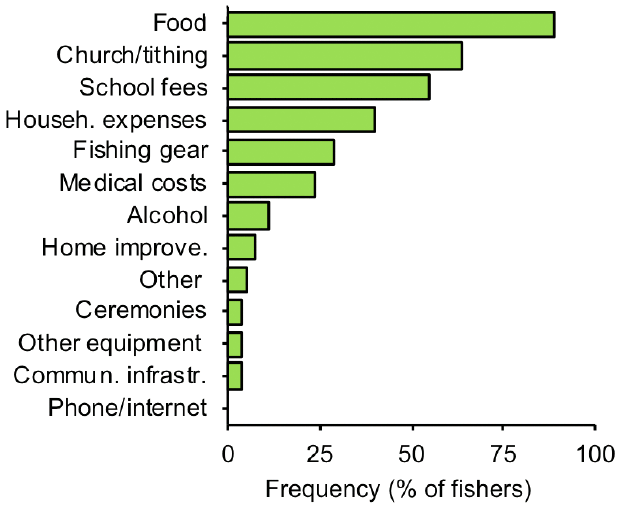
Fig. 6 . Proportion of fishers responding on which items they spent the extra income earned from trochus ( Rochia nilotica ; only fishers who sold trochus and reported earning greater income, n =